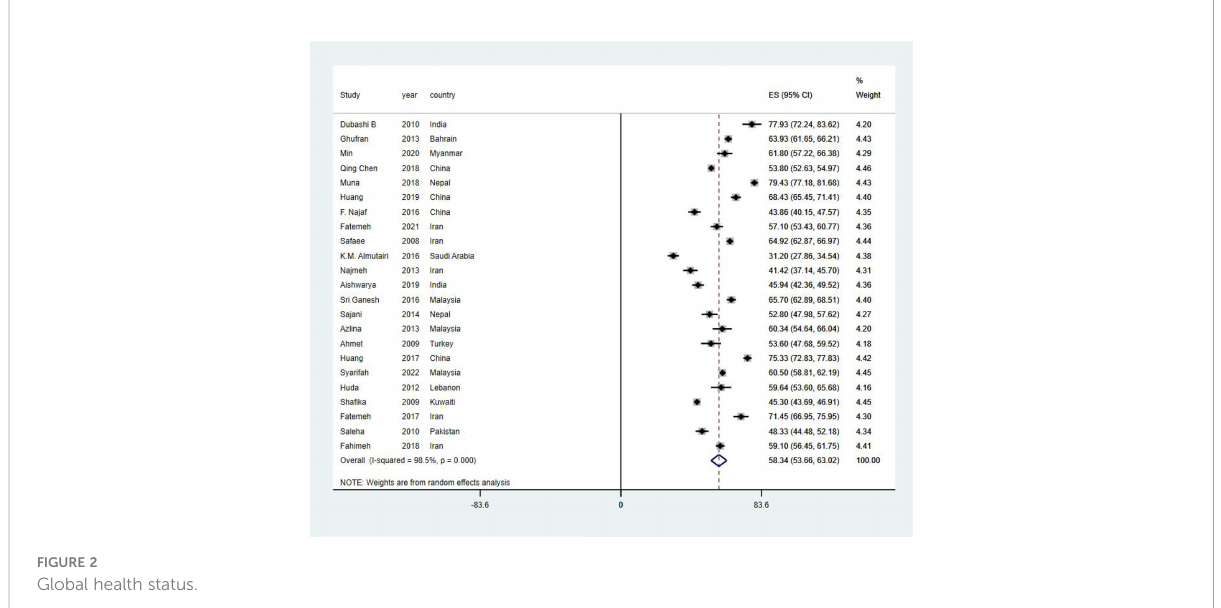
FIGURE 2 Global health